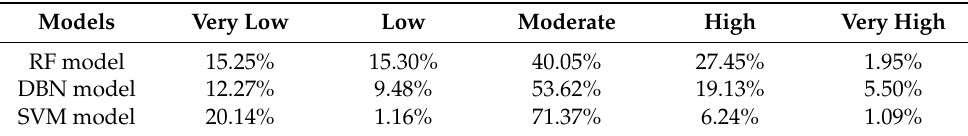
Table 3. Area percentages of various susceptibility levels.